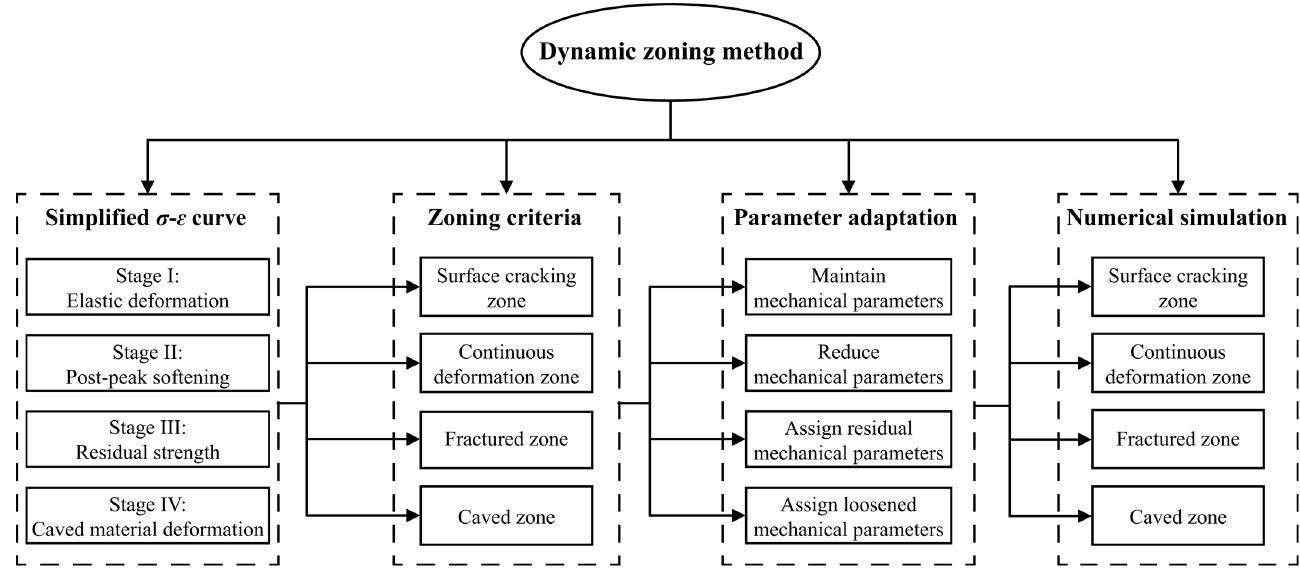
Figure 2. Outline of the dynamic zoning method.